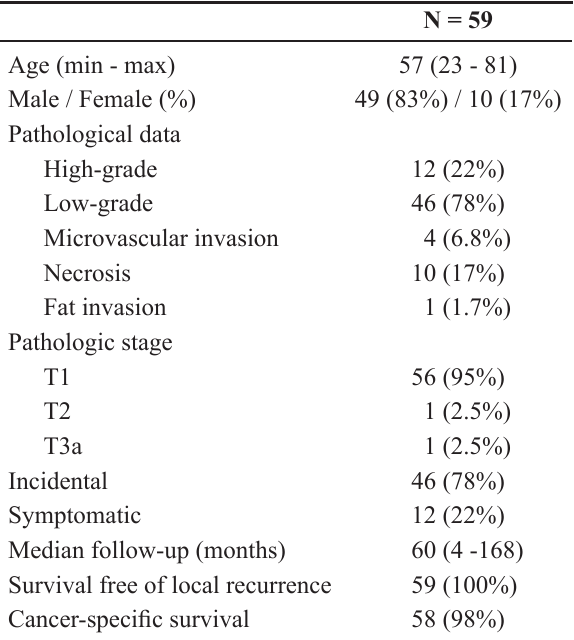
Table 5 – Demographic data and pathology results of 59 excised tumors in nephron sparing surgery.